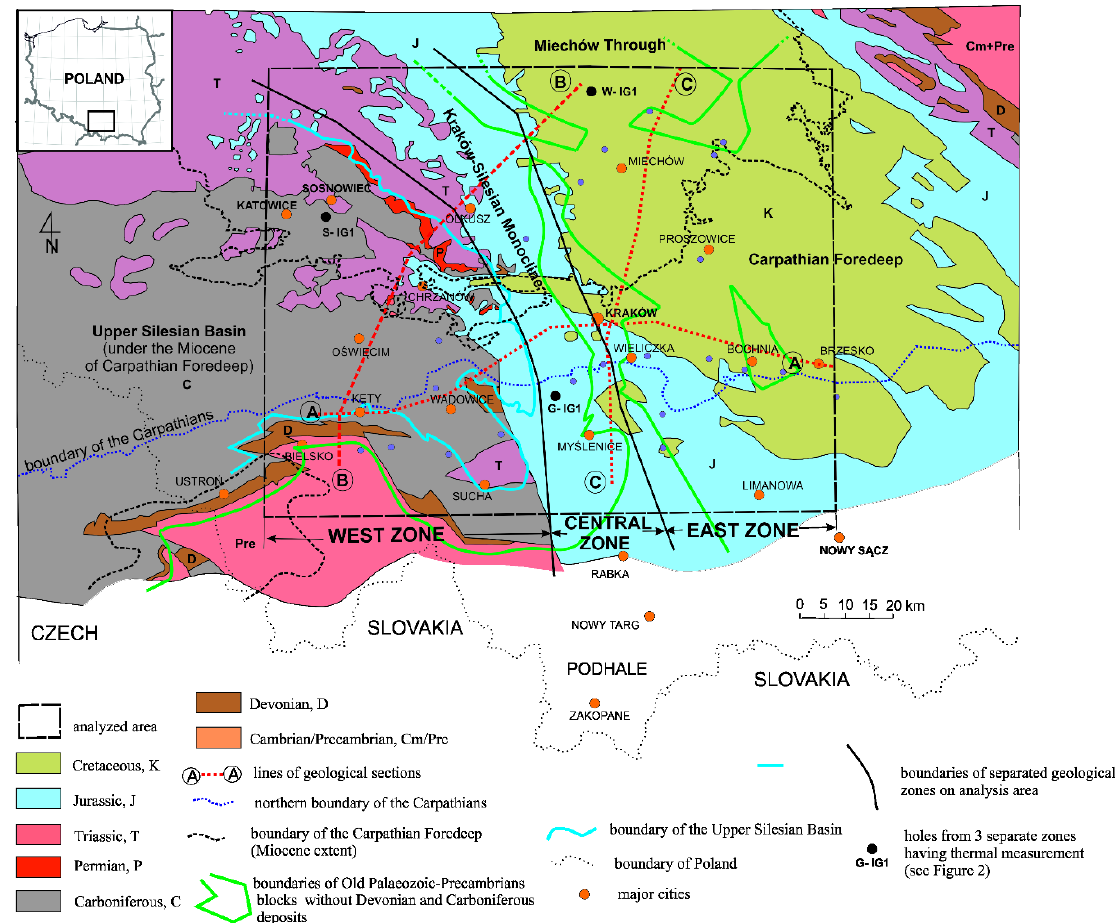
Figure 1. Geological map of analyzed area without Quaternary formations (after [1], modified).